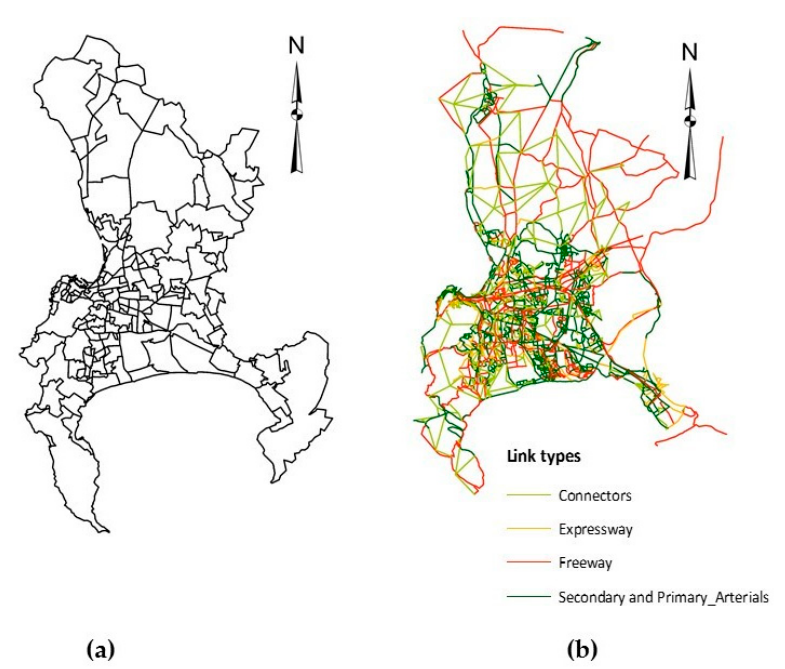
Figure 3. ( a ) The Traffic Analysis Zone (TAZ) boundaries; ( b ) the road network and link types used in the Cape Town model .